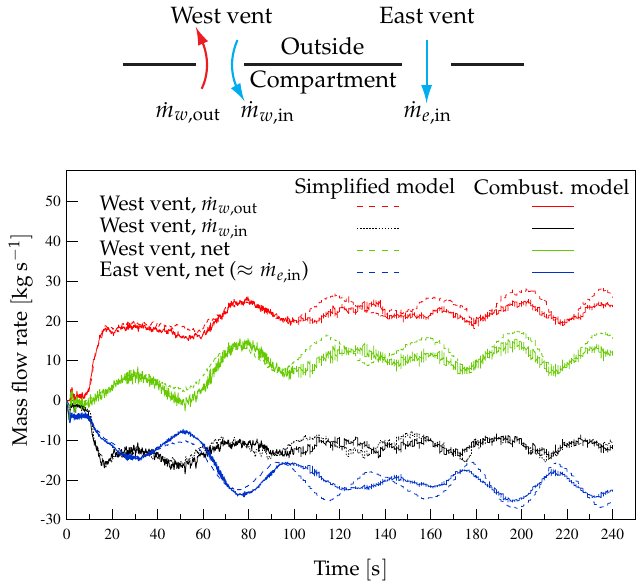
Figure 12. Results similar to those of Figure 5b, but obtained as in Figure 8.